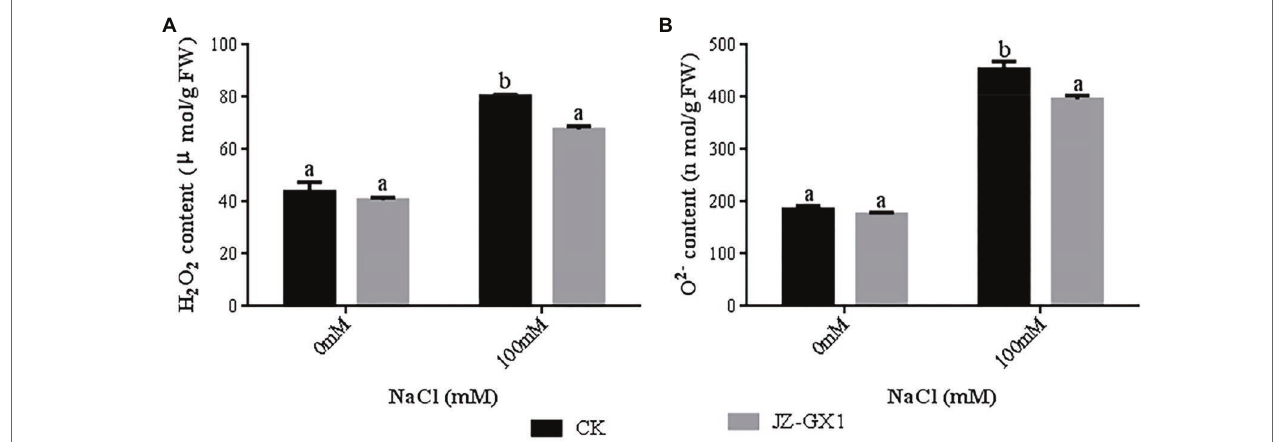
FIGURE 6 | Effect of volatile gases produced by R. aquatilis JZ-GX1 on the H 2 O 2 content of R. pseudoacacia . (A) H 2 O 2 content; (B) O 2 −